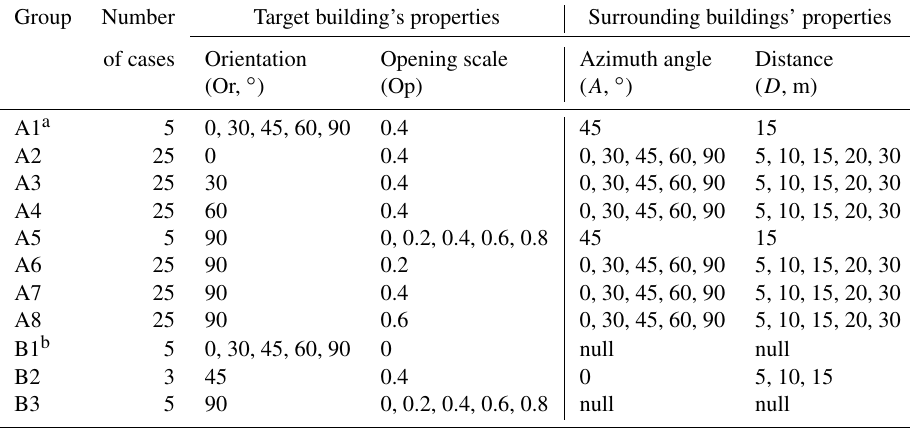
Table 1. Simulation conditions. Group Number Target building’s properties Surrounding buildings’